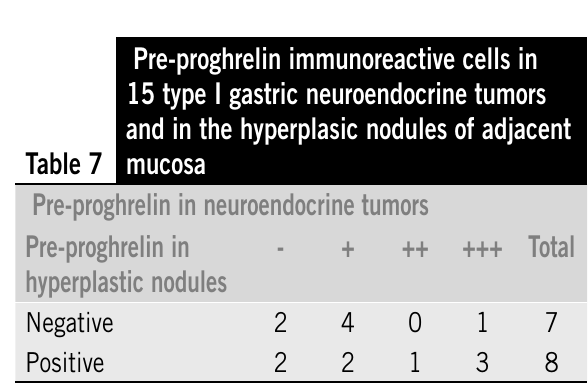
Study of correlation between the degree of immunohistochemical reaction for chromogranin and pre-proghrelin in 15 gastric type I neuroendocrine